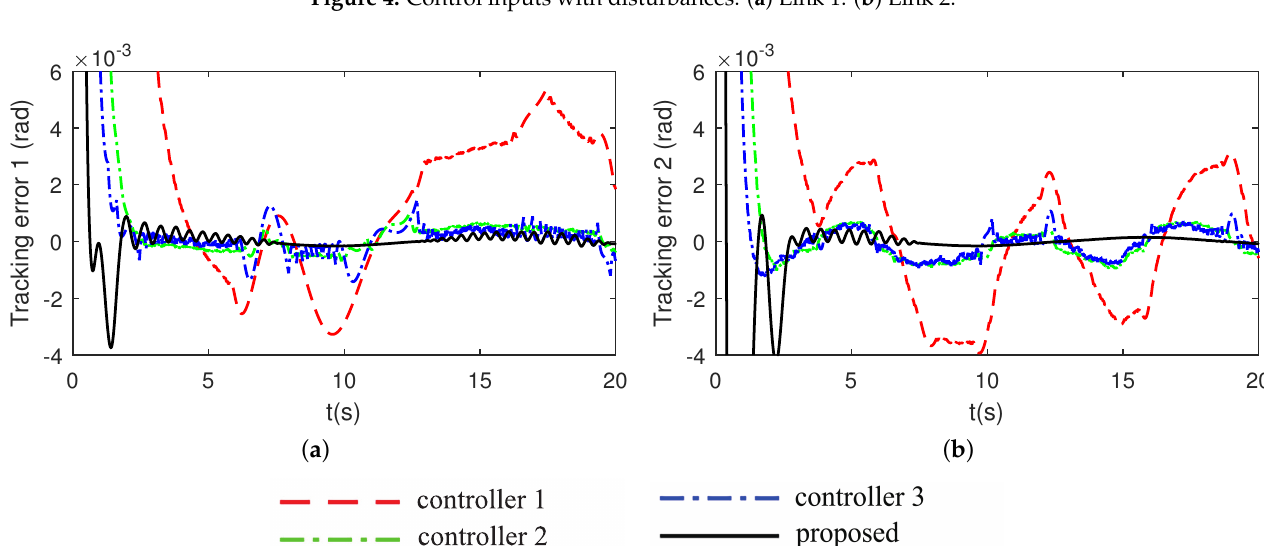
Figure 5. Tracking errors with disturbances: ( a ) Link 1. ( b ) Link 2.